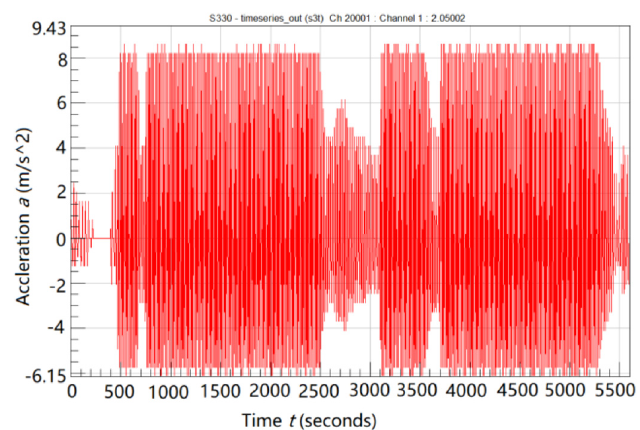
Fig. 8. Layout of acceleration sensor on the slider.